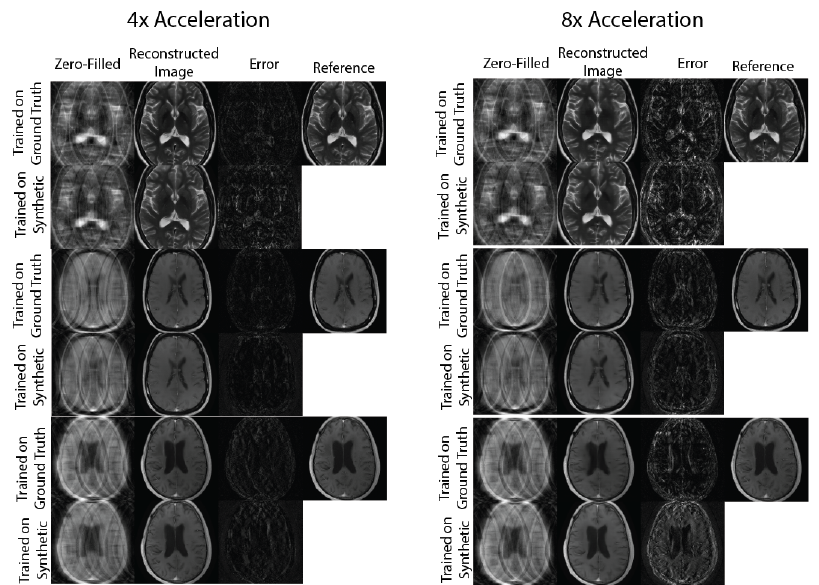
Figure 4. Sample image comparisons at 4 × and 8 × acceleration factors for the 16-coil dataset. The columns compare the zero-filled image, reconstructed image, and error maps generated with 2 Variational Networks trained on ground truth and synthetic k -space.